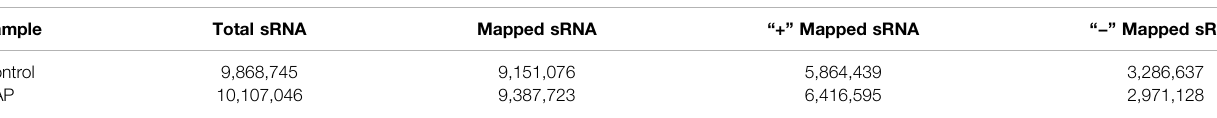
TABLE 2 | Reads mapping to the reference sequence